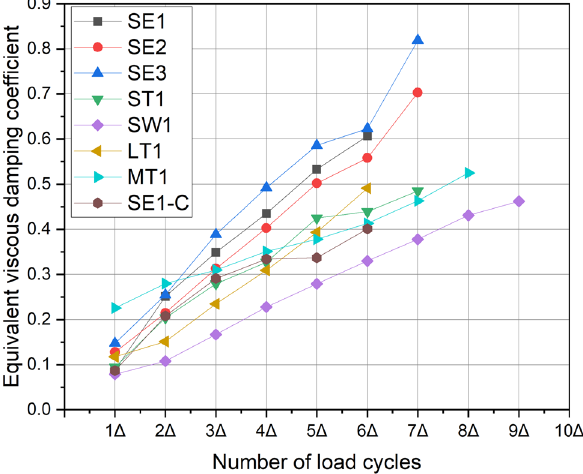
Figure 12: Curves of ζ eq vs Δ of typical